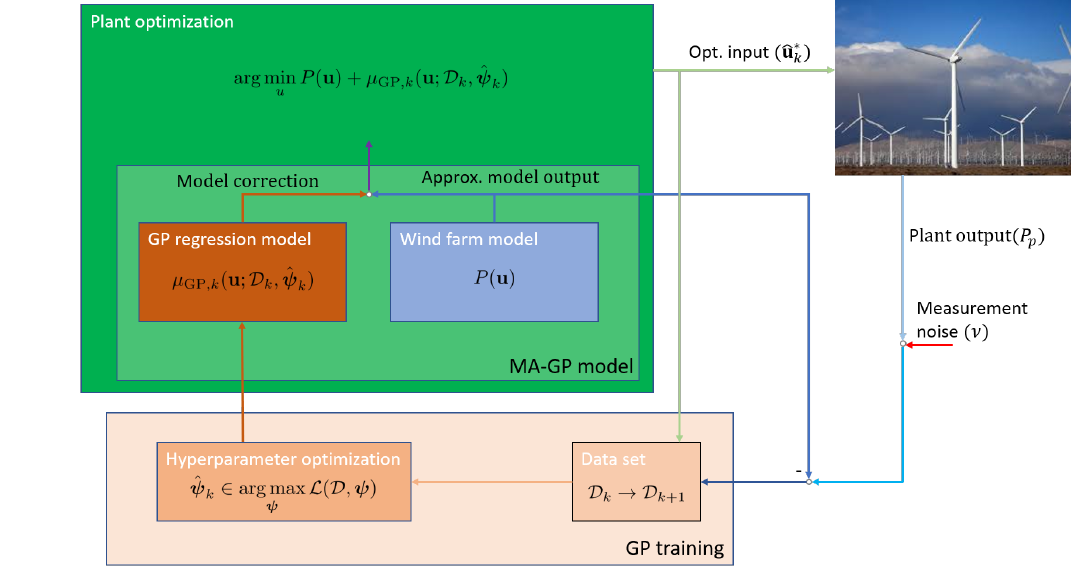
Figure 1. The basic idea of the MA–GP scheme for a wind farm. The GP regression model creates an input–output map of the control inputs to the plant–model mismatch. In the MA–GP model the GP regression model is used to correct the output of the approximate model. This MA–GP model is used in the optimization to compute optimal control inputs for the wind farm. The inputs and the difference between the measured and estimated output of plant and model, respectively, are used to update the data set D and the hyperparameter ψ . The measured outputs of the plant are corrupted by noise. The photo of a wind farm is by Erik Wilde from Berkeley, CA, USA, https://www.flickr.com/ photos/dret/24110028330/ (last access: 9 July 2020), Wind turbines in southern California 2016 , https://creativecommons.org/licenses/by-sa/ 2.0/legalcode (last access: 9 July